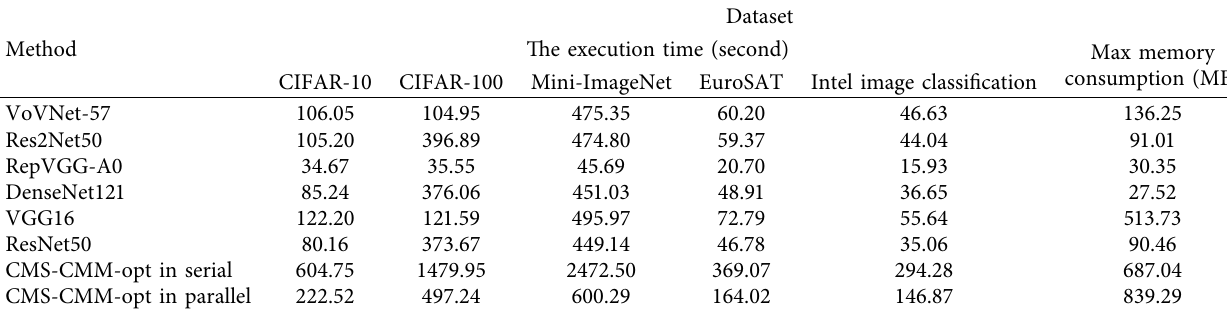
Table 6: Execution time and memory consumption.